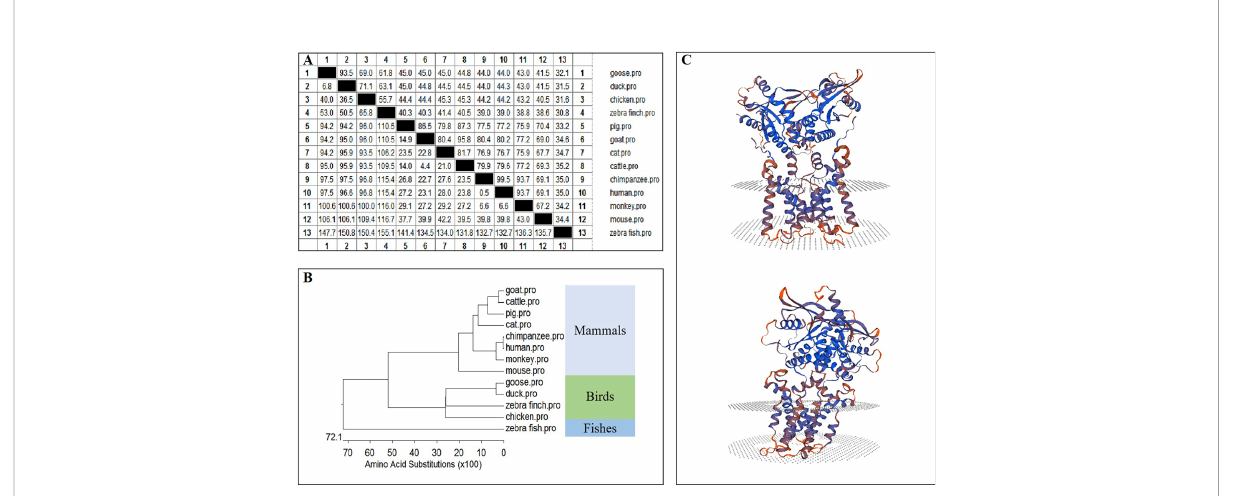
FIGURE 2 (A) The amino acid sequence homology of different animals. (B) Phylogenetic tree of the deduced amino acid sequence of GoSTING and other animal STING proteins. (C) Three-dimensional structure of GoSTING predicted by